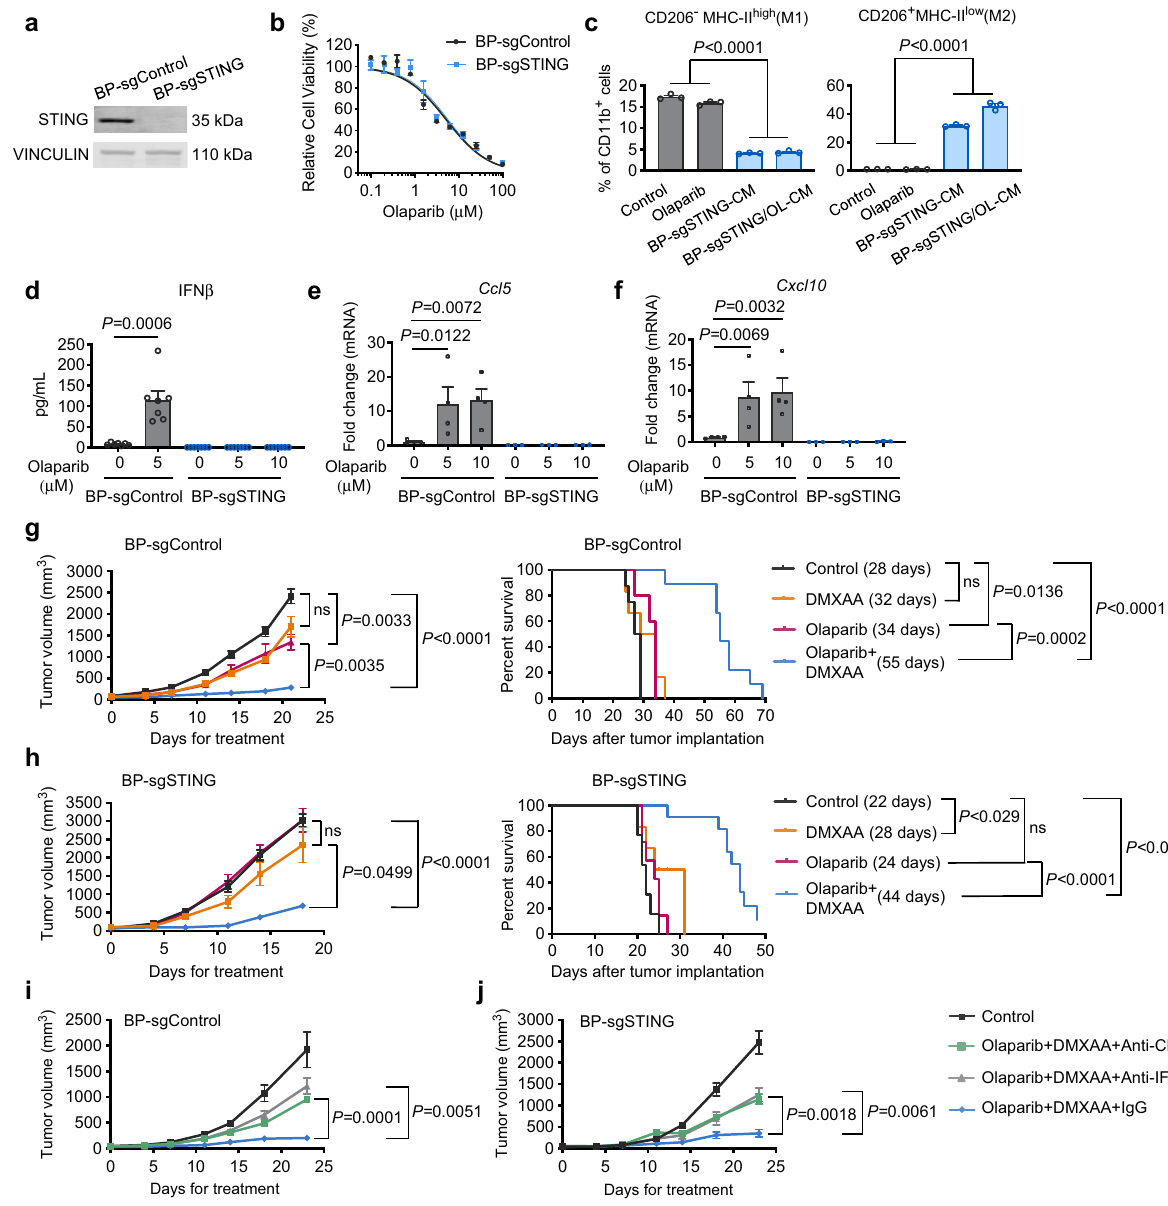
Fig. 6 Systemic delivery of a STING agonist sensitizes STING-null BP tumors to olaparib in vivo. a Western blots for STING and VINCULIN in CRISPR/ Cas9 control and STING knockout BP tumor cells (BP-sgControl and BP-sgSTING). Representative blots of two independent experiments are shown. b CellTiter-Glo analysis showing cell viability of BP-sgControl and BP-sgSTING cells after 3 days of treatment with serial dilution of olaparib ( n = 3). c Flow cytometry analysis of mouse BMDMs treated with DMSO vehicle control, olaparib (OL, 5 μ M), 50% BP-sgSTING-CM, or 50% BP-sgSTING/OL-CM for two days ( n = 3). d ELISA analysis of IFN β in media from BP-sgControl or BP-sgSTING cells with or without 2 days of olaparib treatment ( n = 7). e and f RT-qPCR analysis of Ccl5 ( e ) and Cxcl10 ( f ) in BP-sgControl and BP-sgSTING cells treated with or without olaparib for 2 days (BP-sgControl, n = 4; BP-sgSTING, n = 3). g Tumor growth (left) and survival (right) of BP-sgControl tumor-bearing FVB mice treated with olaparib (50mg/kg, IP, QD), DMXAA (10mg/kg, IP) or olaparib + DMXAA. Median survivals are shown in parentheses. Left, Control, n = 13; Olaparib, n = 7; DMXAA, n = 9; Olaparib + DMXAA, n = 14. Right, Control, n = 8; olaparib, n = 5; DMXAA, n = 6; olaparib + DMXAA, n = 9. h Tumor growth (left) and survival (right) of BP-sgSTING tumor-bearing FVB mice treated with olaparib (50mg/kg, IP, QD), DMXAA (10mg/kg, IP) or olaparib + DMXAA. Median survivals are shown in parentheses. Left, Control, n = 24; olaparib, n = 11; DMXAA, n = 9; olaparib + DMXAA, n = 19. Right, Control, n = 13; olaparib, n = 7; DMXAA, n = 6; olaparib + DMXAA, n